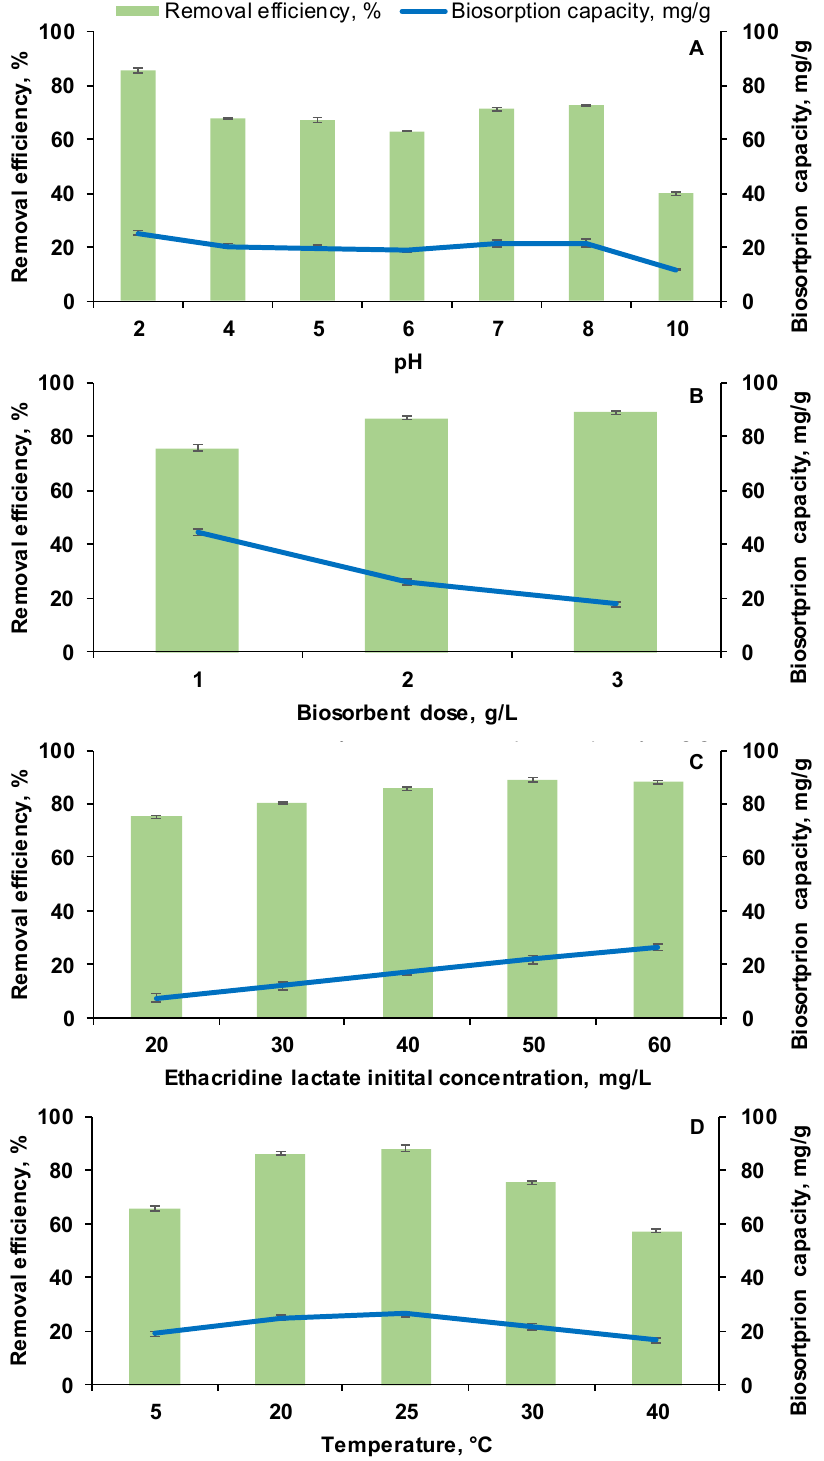
Figure 6. Effect of working conditions on EL removal efficiency and on the biosorption capacity ( A ): influence of pH (EL solution volume: 10 mL; EL initial concentration: 60 mg/L; biosorbent dose: 2 g/L; room temperature); ( B ): influence of biosorbent dose (EL solution volume: 20 mL; EL initial concentration: 60 mg/L; pH: 2; room temperature); ( C ): influence of EL initial concentration (EL solution volume: 30 mL; biosorbent dose: 2 g/L; pH: 2; room temperature); ( D ): influence of temperature (EL solution volume: 10 mL; EL initial concentration: 60 mg/L; biosorbent dose: 2 g/L; pH: